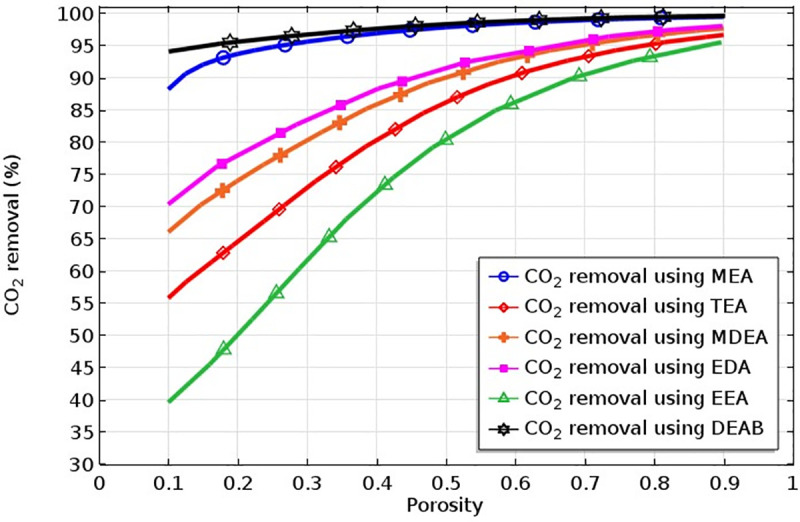
Impact of the membrane porosity parameter on the CO2 removal applying MEA, TEA, EEA, EDA, MDEA and DEAB liquid absorbents.